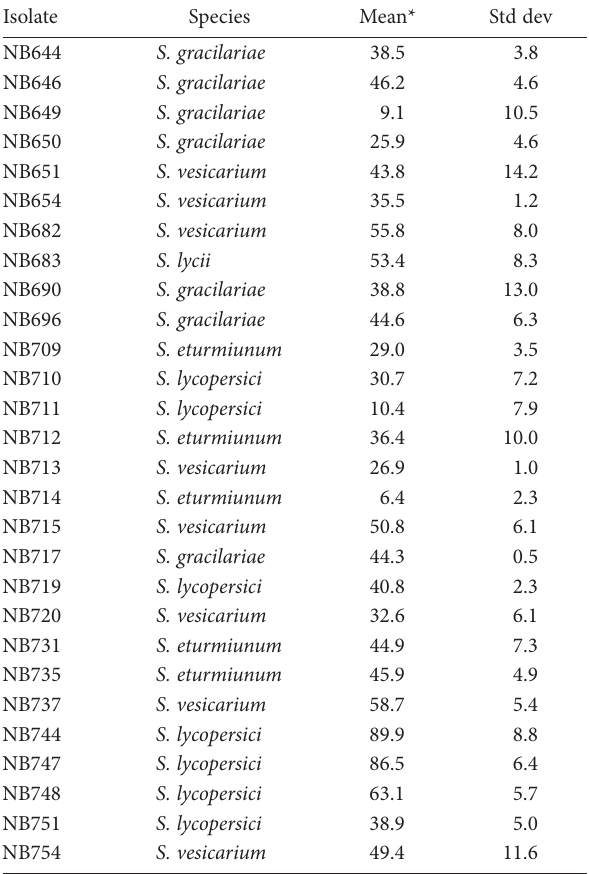
Table 2. Mean percentages of leaf necrotic area (l.n.a) recorded on tomato plants inoculated with different Stemphylium isolates at 21 d after inoculations.